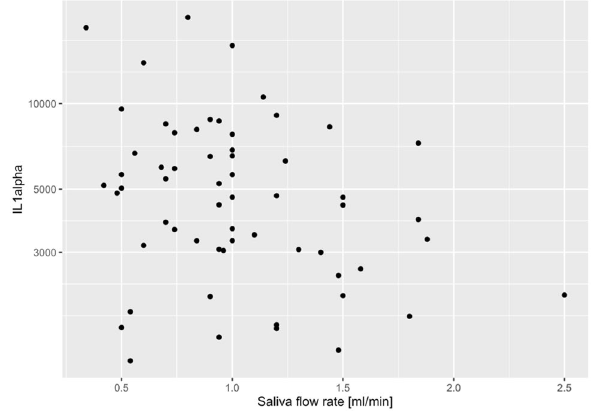
Figure 4. The figure shows the distribution of IL1-alfa (Interleukin-1alpha) in the saliva of 30 children with a diagnosis of JIA and in the 30 healthy controls (CTR) together (n = 60). IL1alpha showed indication of the association with saliva flow (unadjusted p <